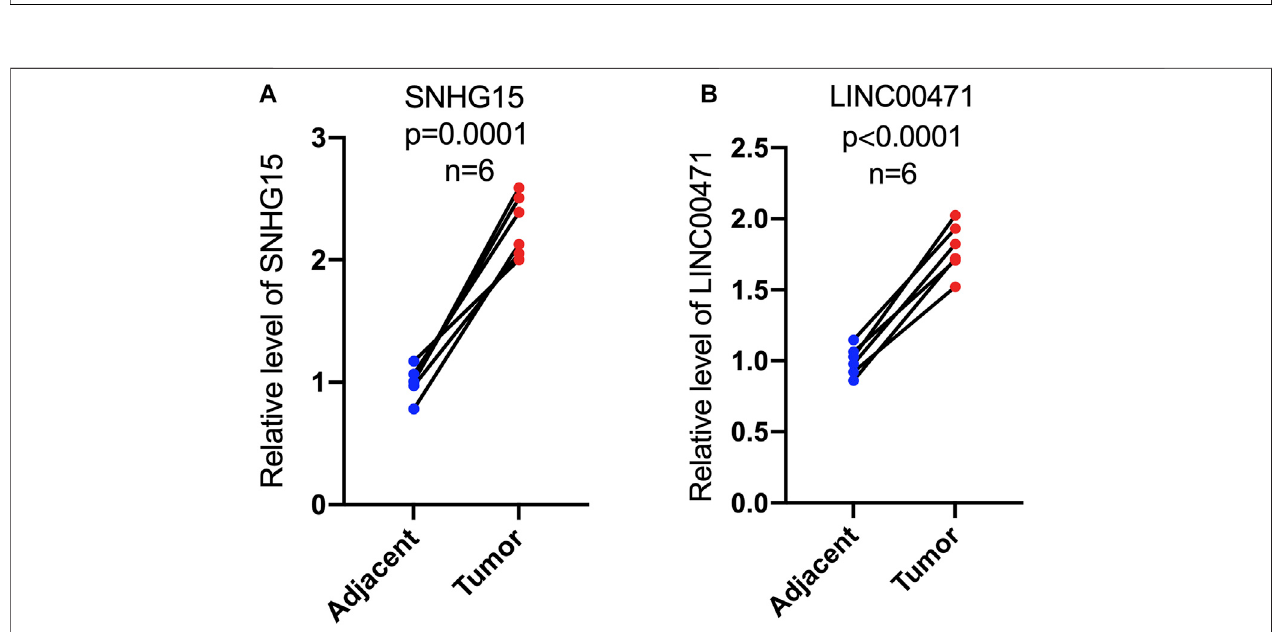
Frontiers in Genetics |